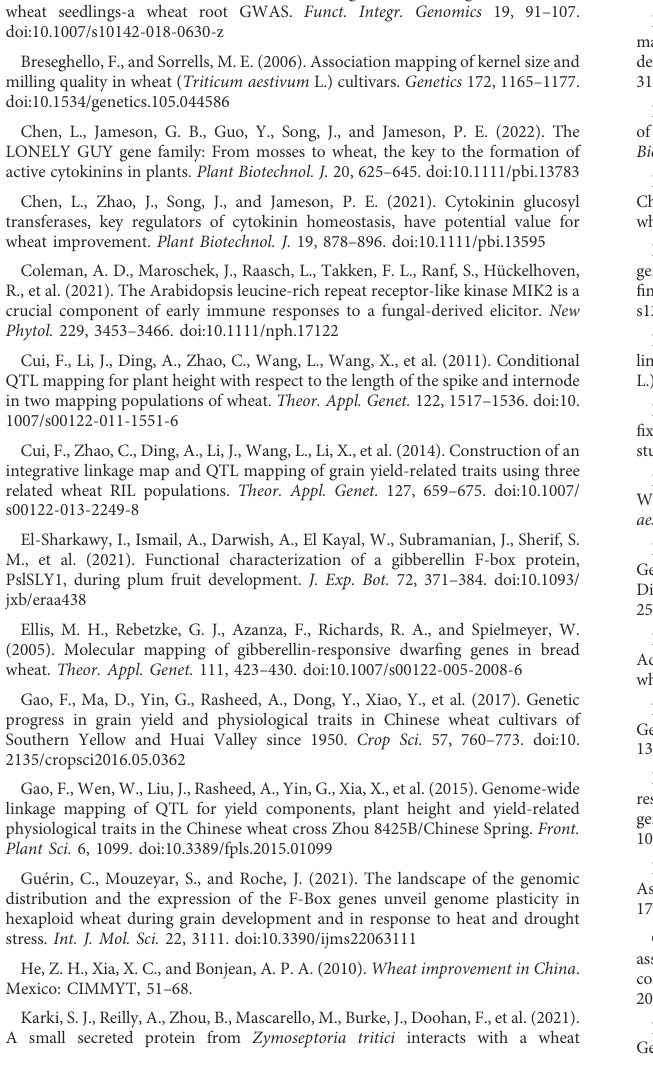
SUPPLEMENTARY FIGURE S1 The qRT-PCR results of the seven candidate genes for the extreme accessions of the 25 spring wheat accessions from the Northeast of China. The extreme accessions of the 25 spring wheat accessions from the Northeast of China were according to Supplementary Table